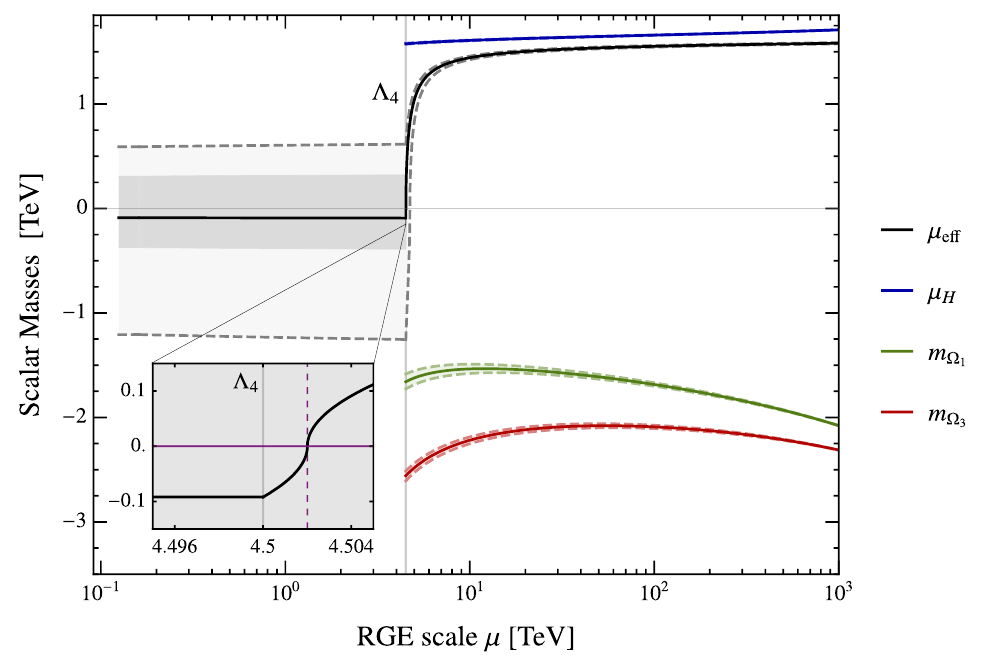
, m 2 , m 2 , and µ 2 . H Ω 1 Ω 3 eff ). The inset H , m Ω 1 , m Ω 3 , µ eff = 4 . 5 TeV. We 4 5% at Λ . This i | ≤ UV from the smaller variations δ ( λ, η, ρ ) in eff i